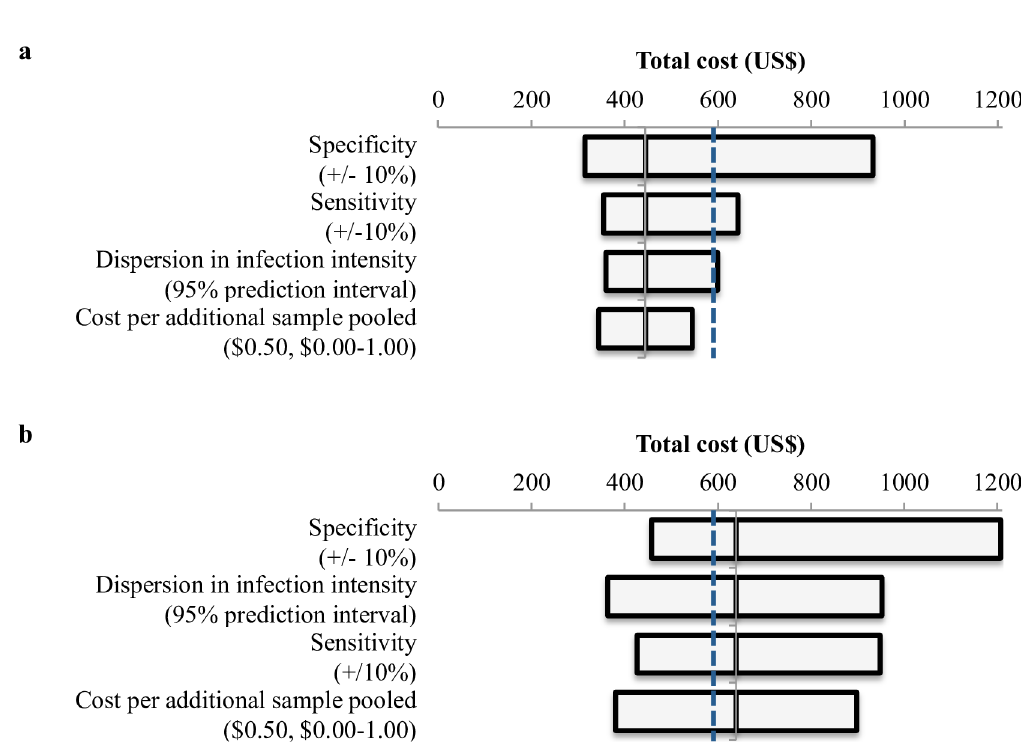
Fig 4. One-way sensitivity analysis of microsimulation. This analysis tested the effect of changing individual model parameters on the total cost of the urine pooling strategy for (a) pool of 4 and (b) pool of 8. The horizontal bar represents the total cost to achieve 90% level of certainty ( ± 5% around the prevalence threshold) in classification across a range of values for the tested parameter. The y-axis (solid black line) represents the total cost of the urine pooling strategy under base case assumptions. The vertical dashed blue line represents the total cost of traditional stool microscopy under base case assumptions, and all strategies to the left of this line indicate a cost saving advantage of the urine pooling